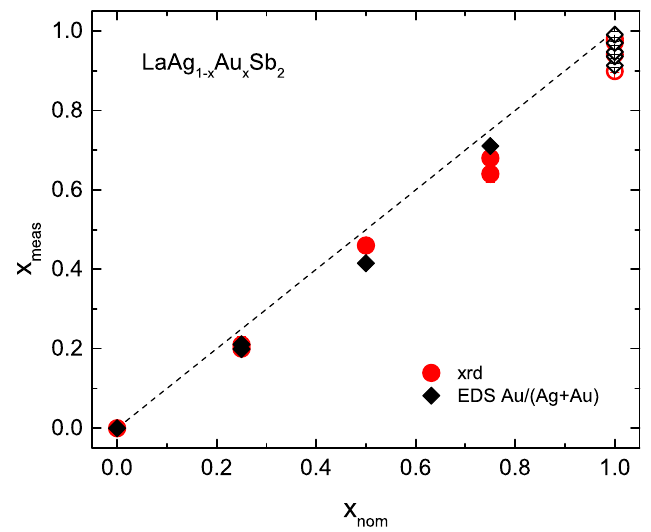
Figure 2. Measured vs. nominal values of Au concentration x in LaAg 1 − x Au x Sb 2 (filled symbols). Double filled red circles for x nom = 0.25 (not clearly discerned on the plot) and 0.75, as well as double filled black rhombi for x nom = 0.25 correspond to T2 and T6 growths, see Section 2. These data are presented in the Appendix A in a tabular form (Tables A2 and A3). For example, of two red circles at x nom = 0.75, higher corresponds to T2 and lower to T6 growth. Data for LaAu x Sb 2 [17] (open symbols) are added for the reference, here again multiple symbols correspond to different initial La:Au:Sb growth compositions [17]. Dashed line corresponds to x meas = x nom . The lattice parameters, unit cell volume and the c / a ratio as a function of Au substitu- tion are presented in Figure 3. All these quantities have an approximately linear dependence of x , in good agreement with Ref.